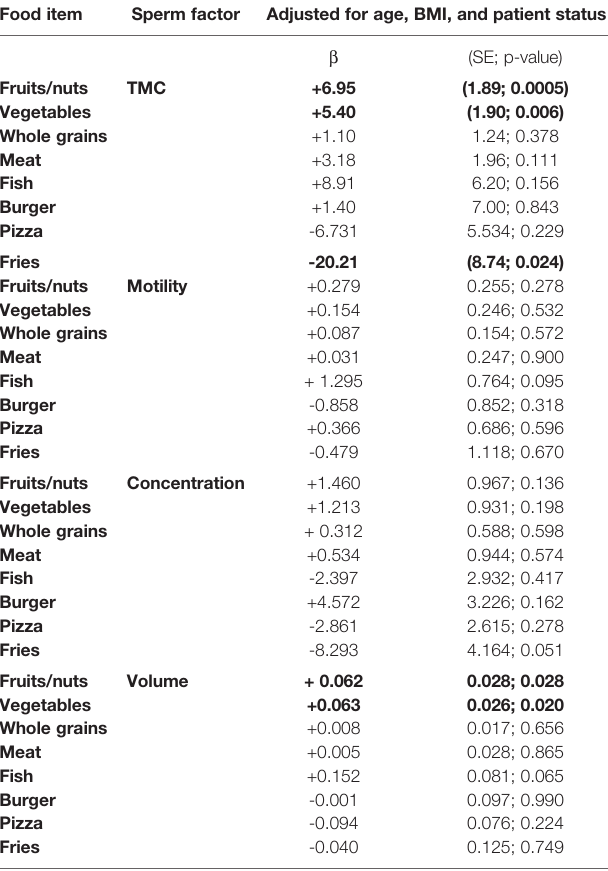
TABLE 2 | Reported daily foods versus weekly foods.